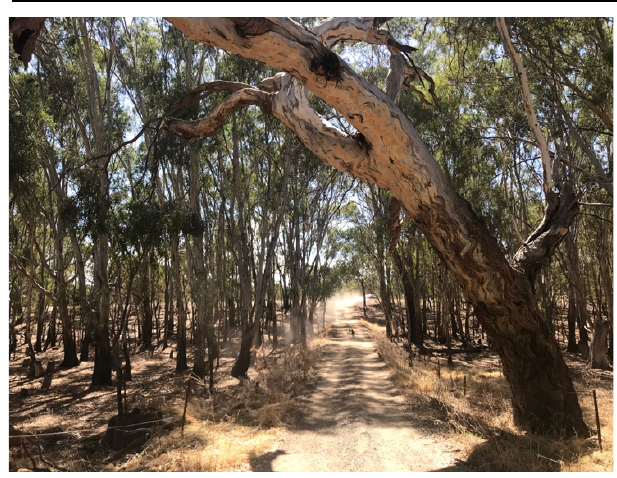
Figure 2 . Deniliquin – the Dirt Road I Took Each Day from My Accommodation to the